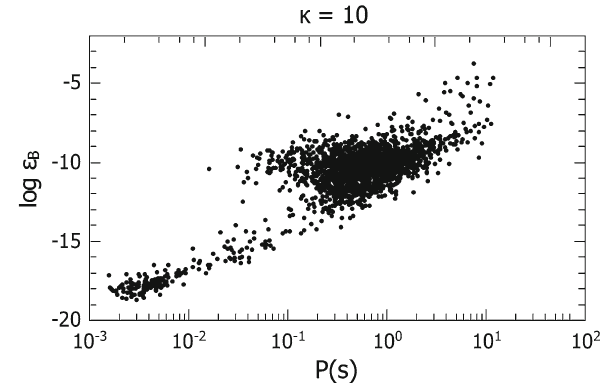
Fig. 2 Correlation between the magnetic ellipticity and the period for all pulsars with known P , ˙ P